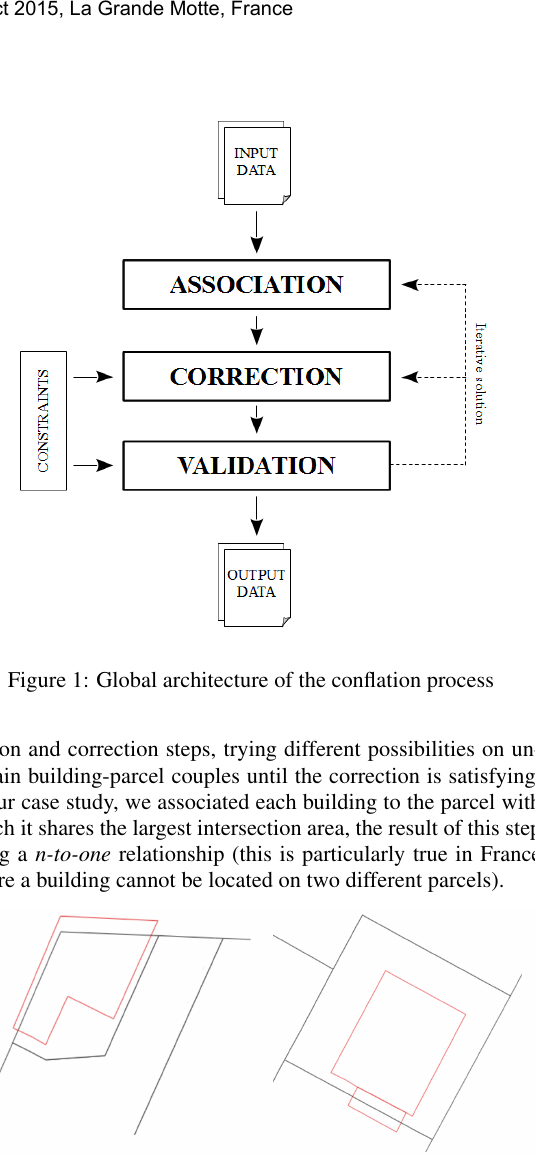
Figure 2: Obvious (left) and ambiguous (right) association cases. Buildings are depicted in red and parcels in